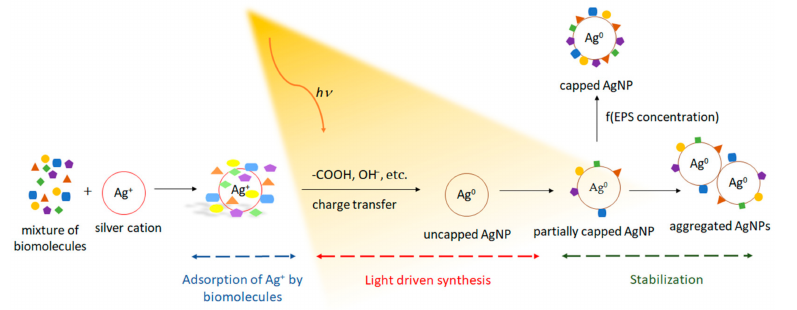
Figure 7. Hypothetical mechanism of the light-driven synthesis of Ag NPs using exopolysaccharides extracted from the green microalga C. reinhardtii . Adapted from [17]. Published by MDPI